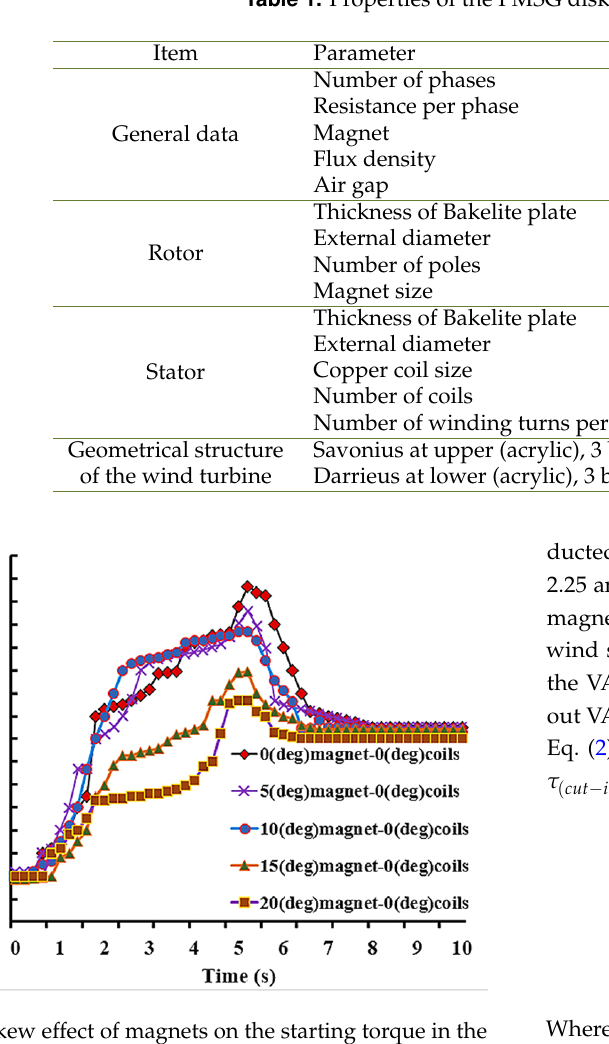
Fig. 3. Skew effect of magnets on the starting torque in the PMSG for operation at wind speed 8 m/s, 120